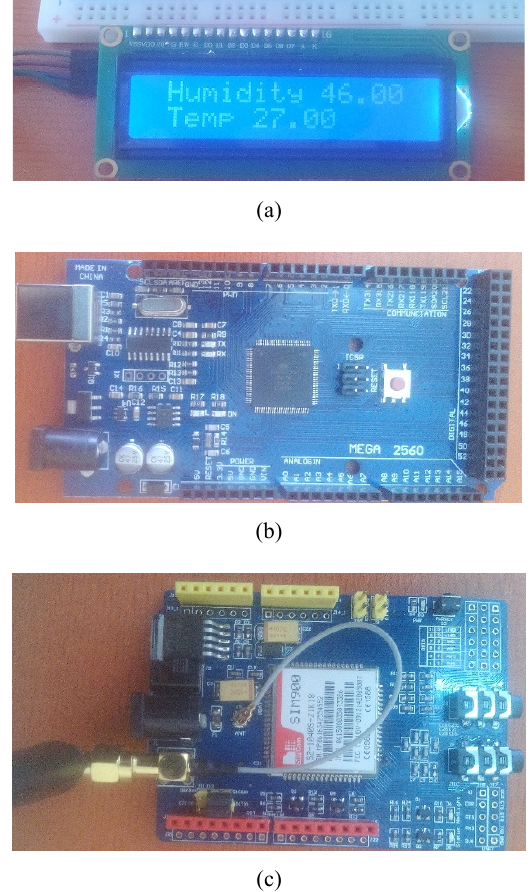
Fig. 5. Coordinator/Gateway node components (a) LCD (b) Arduino Mega (c) GSM SIM 900